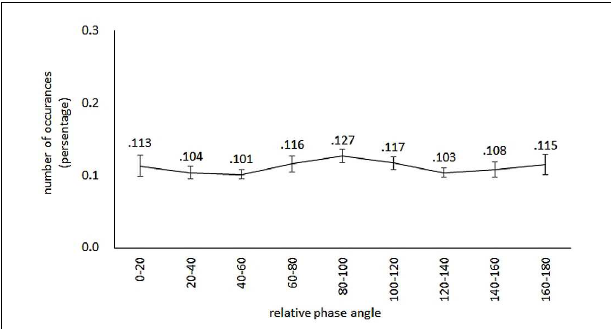
FIGURE 3 | Percentage distribution of relative phase occurrences. The mean value is indicated above the error bar representing the Standard Error. Relative phase is distributed in nine 20 ◦ regions from 0 to 180 ◦ . The distribution is almost equally spread over the nine regions of the relative phase